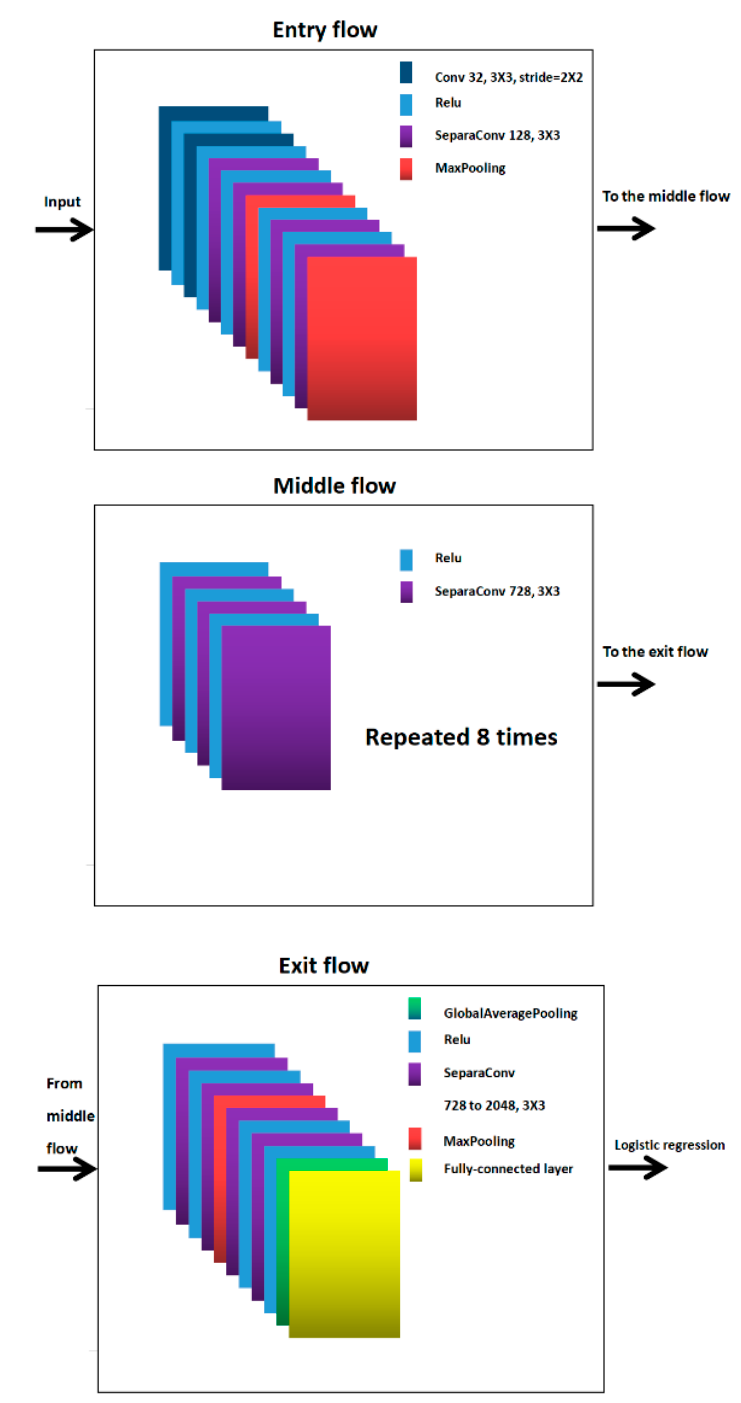
Figure 1. The Xception deep learning network model is divided into three parts: entry flow, middle flow, and exit flow.